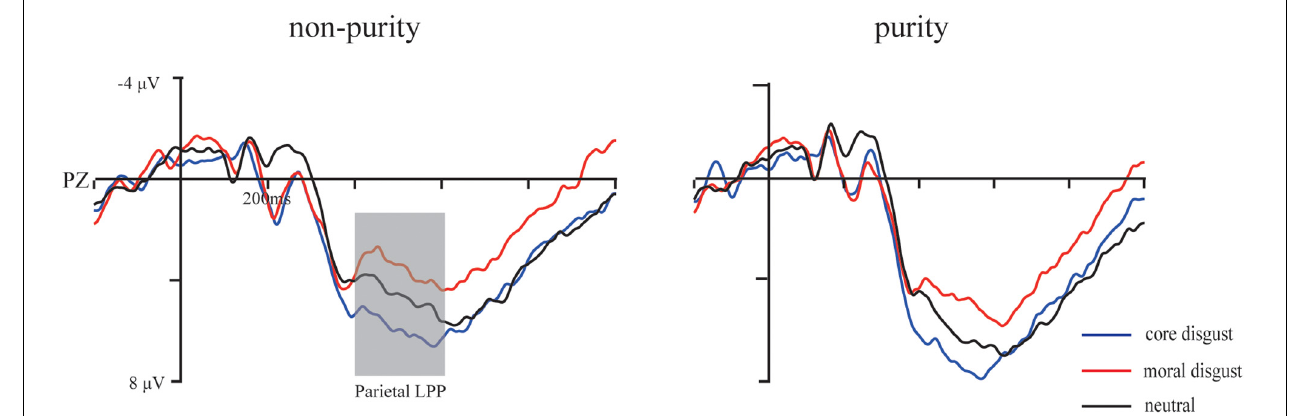
FIGURE 4 | Grand average waveforms for moral disgust, core disgust, and neutral groups under purity conditions at F3, Fz, and F4 electrodes. The gray bar highlights the time window of the parietal LPP (400–600 ms).